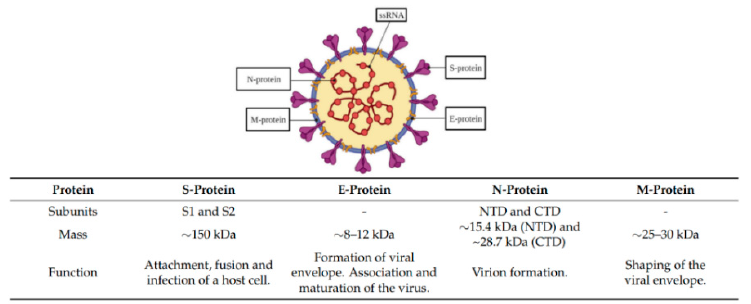
Figure 1. Schematic representation of structural proteins of severe acute respiratory syndrome coro- navirus 2 (SARS-CoV-2) and properties Reprinted with permission from Ref. [5]. 2021,